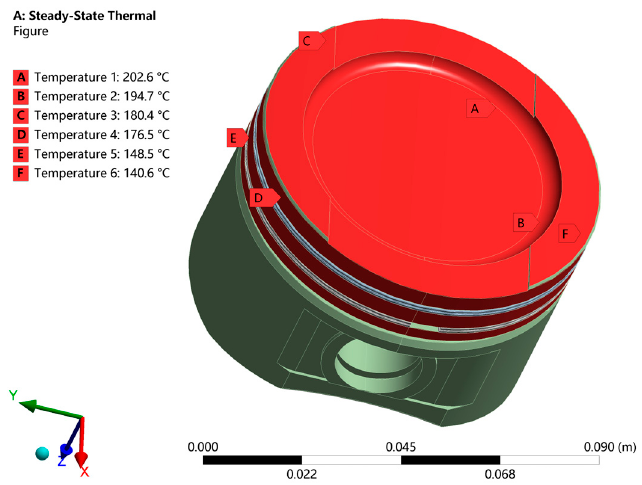
Figure 4. Temperature boundary conditions of the engine piston and piston rings.